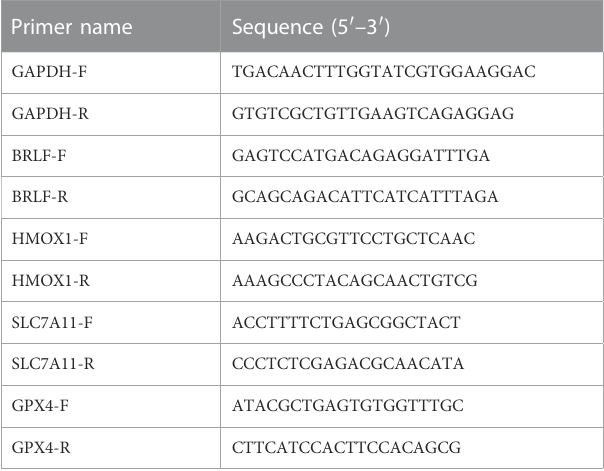
TABLE 3 Primer sequences used for RT-PCR detection. Primer